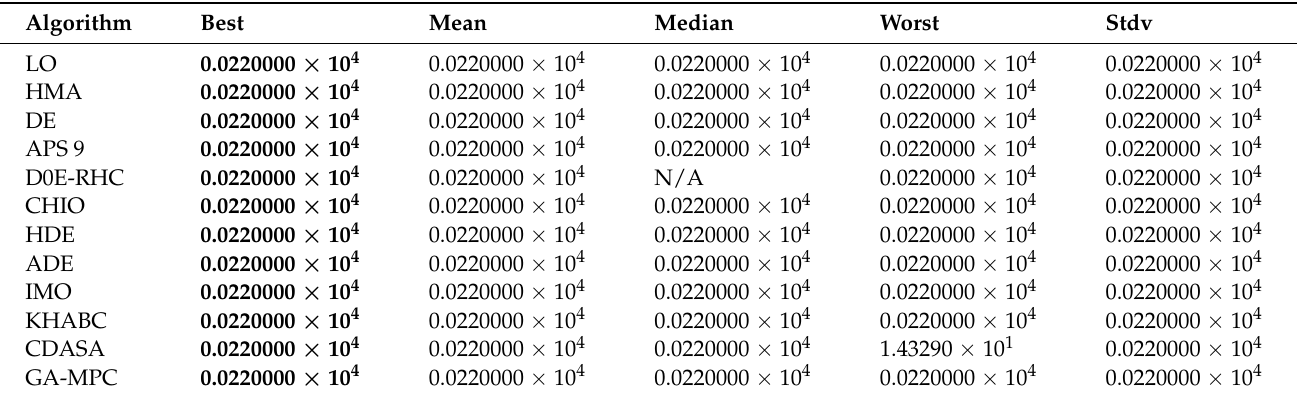
Table 8. The performance of the LO algorithm against other comparative algorithms on transmission network expansion planning problems.